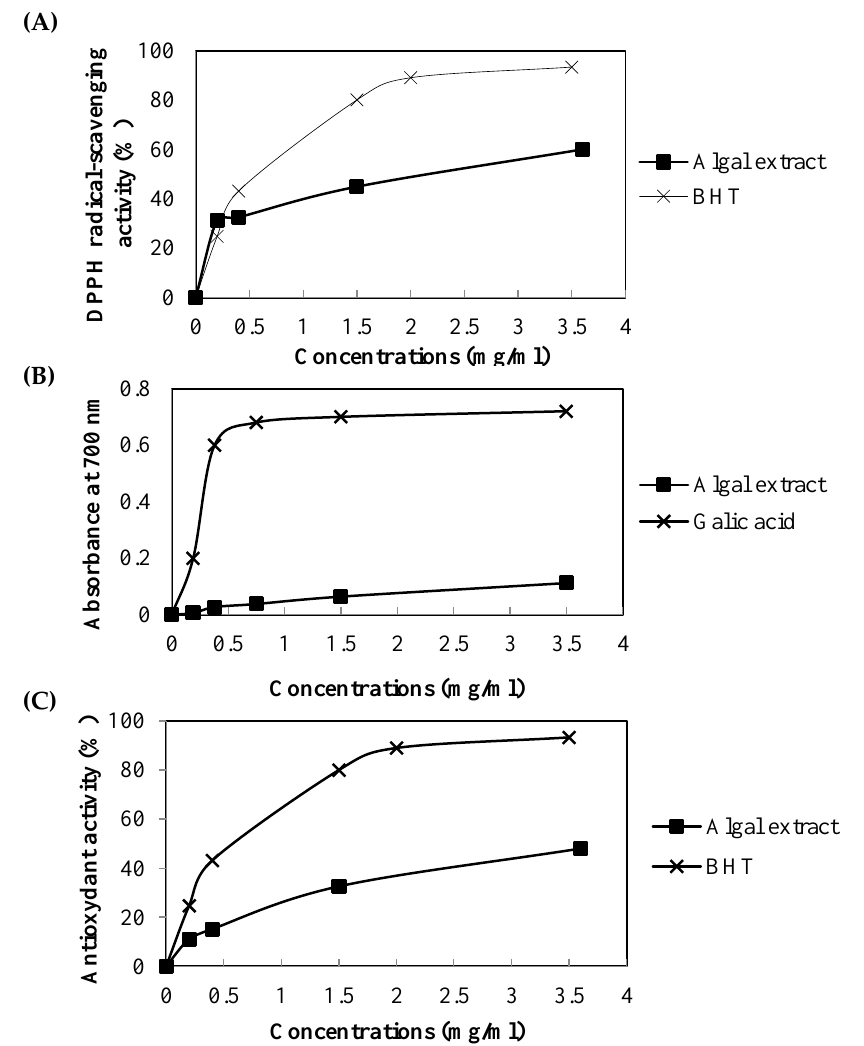
Figure 1. ( A ) DPPH radical-scavenging activity, ( B ) Reducing power; ( C ) ß-carotene bleaching activity of FRE at different concentrations. Vitamin C, gallic acid and BHT were used as positive controls. All analysis was carried out in triplicate. Table 1. Antibacterial power of the tested alga against seven bacteria.